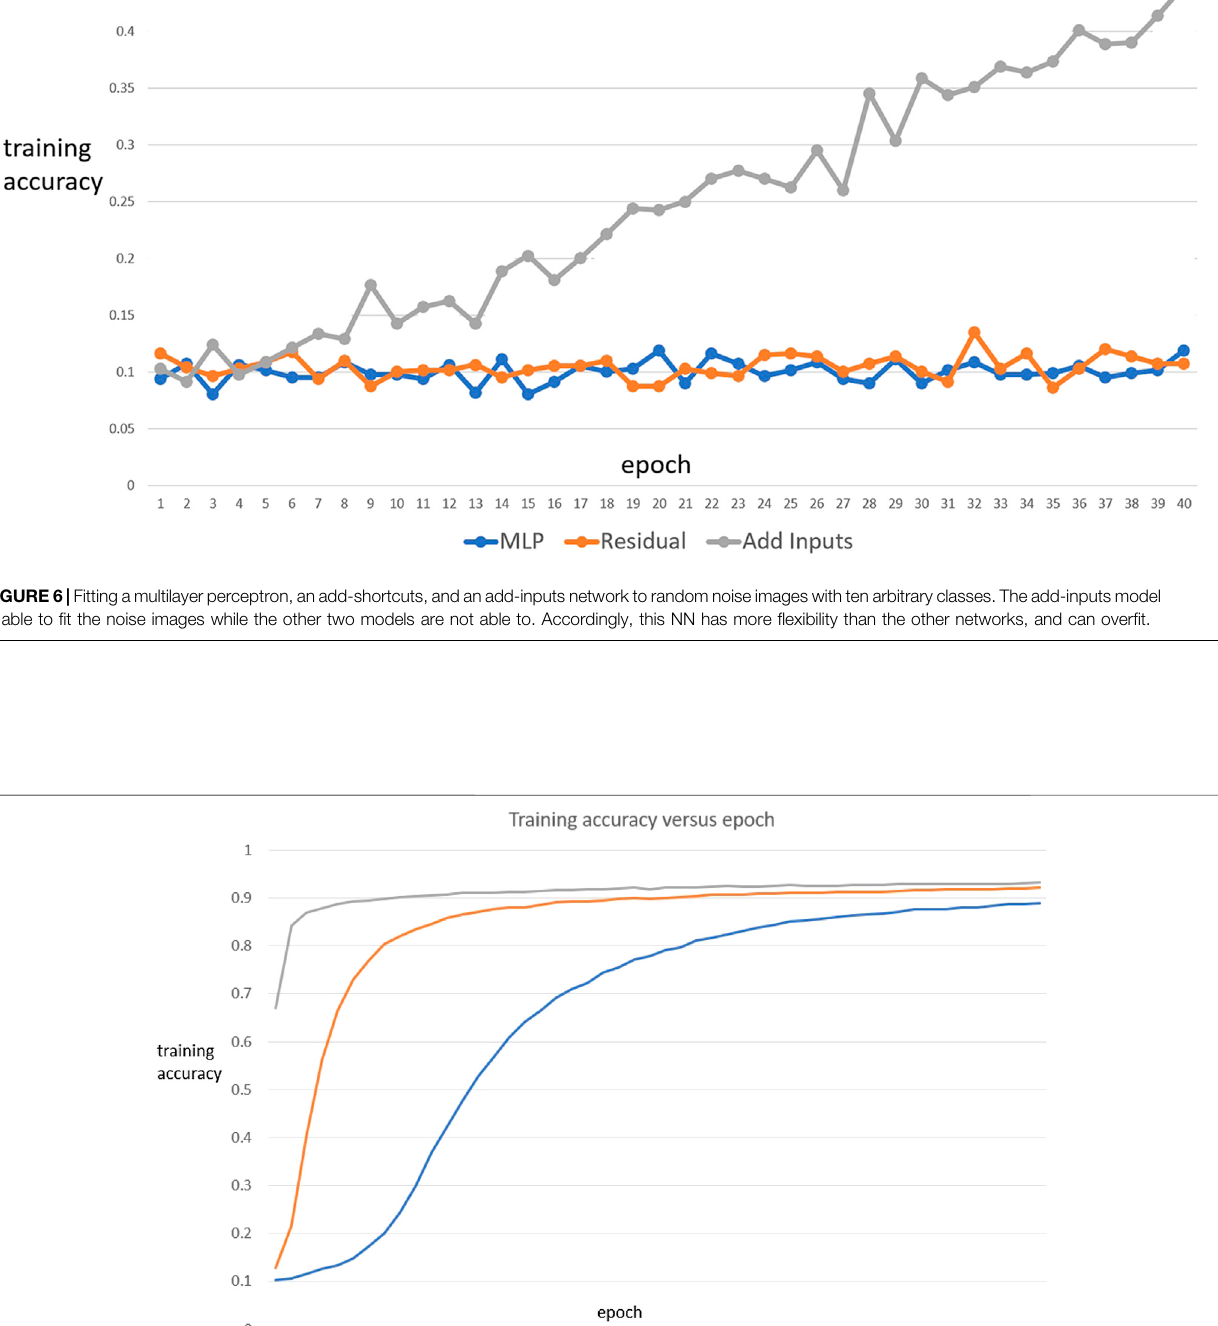
Frontiers in Applied Mathematics and Statistics |